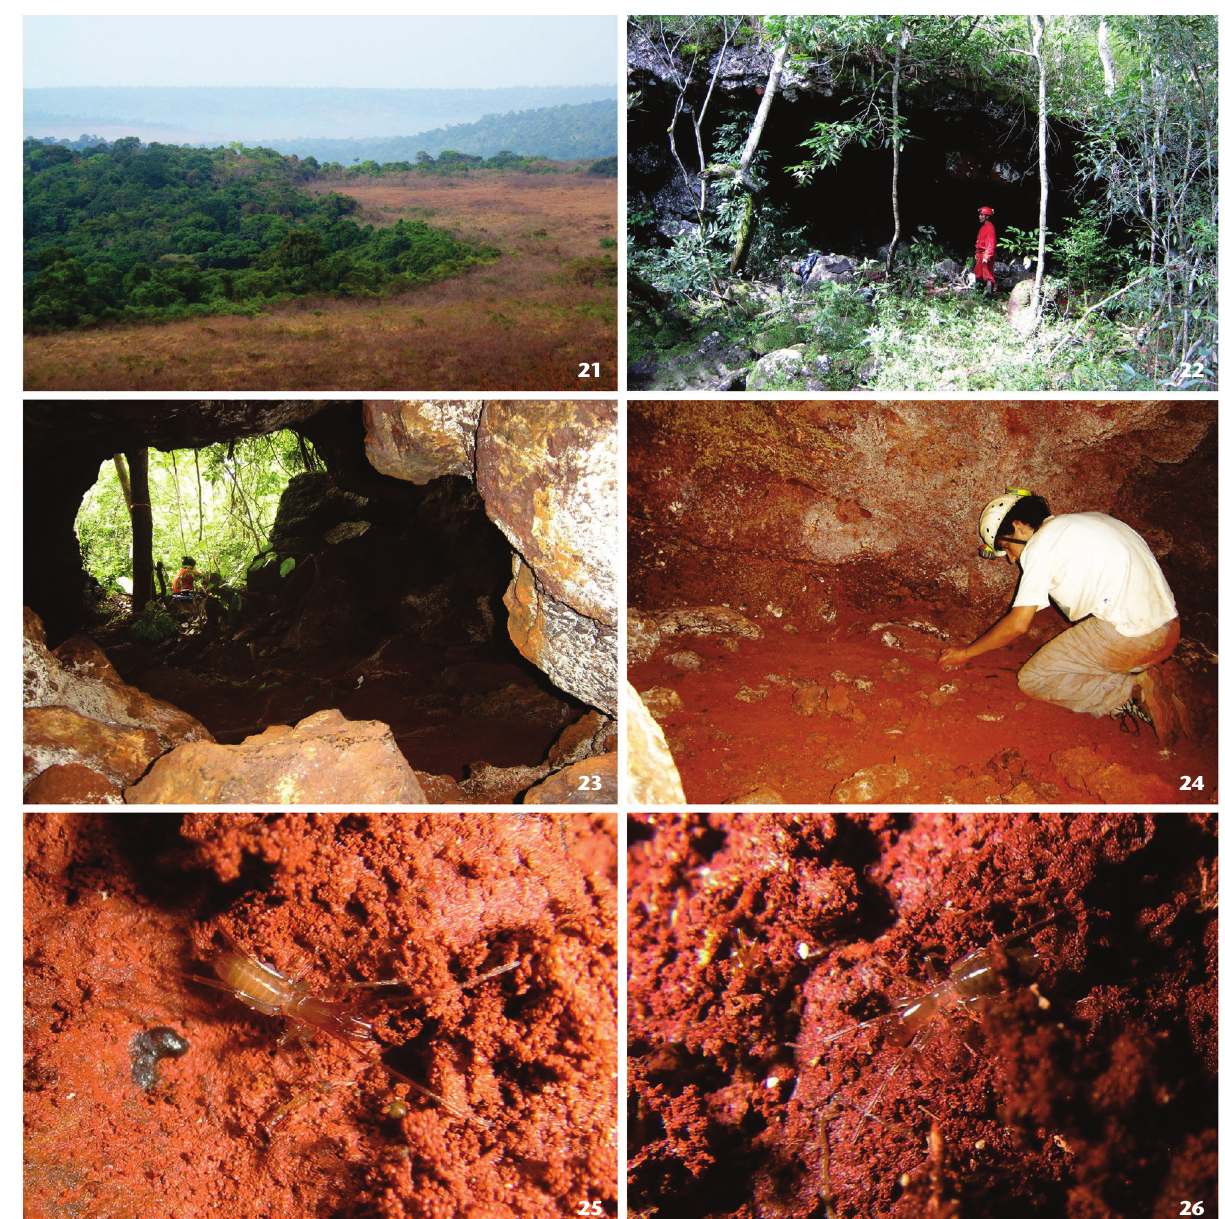
2.30. Leg IV: 0.25; 0.87; 0.42; 0.62; 0.57; 0.25; 3.10. Total length: femur I 0.75-0.93; patella I 0.91-1.13 long; femur IV 0.83-0.91, 2.12. Propeltidium: 1.17 long. Prosoma: 1.27 long. Opisthosoma: 2.2-2.4 longer than wide. Paratypes with one or two setae on 1.57 long (flagellum excluded). Flagellum 0.32 long/0.17 wide. anterior process; two small dorso-submedian depressions slightly Variation (male paratypes). Propeltidium 0.81-0.94 long; deeper than holotype in some ZOOLOGIA 33(2): e20150195 | DOI: 10.1590/S1984-4689zool-20150195 | April 29, 2016 7 / 9